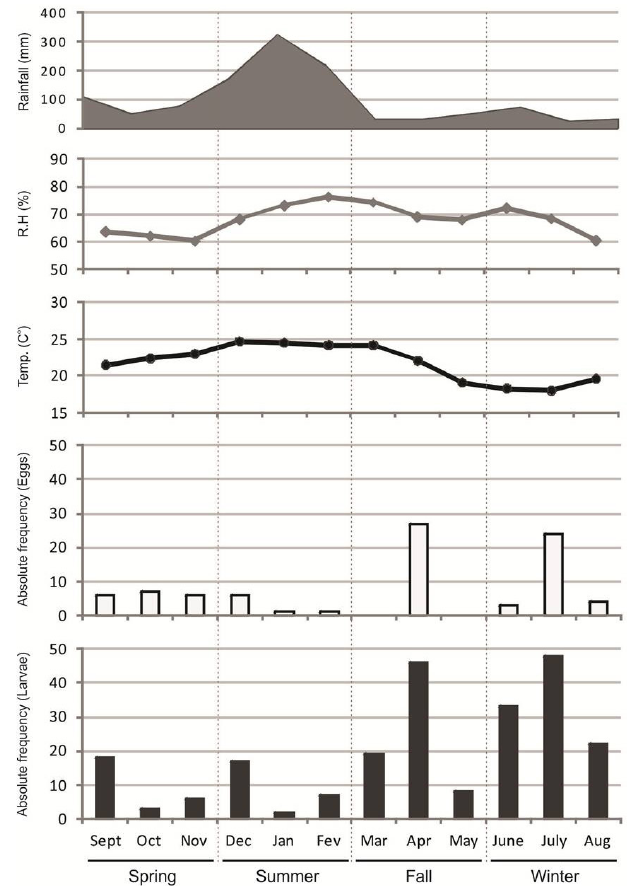
Fig 1 . Graphical interface of absolute frequency (Abs) of disappearance of eggs and larvae from cells of M. montei nests, temperature (° C), relative humidity and rainfall rate (mm) according to the months and seasons from March 1999 to September 2000. Table 1 . Absolute frequency (Abs) and percentage (%) of eggs and larvae removed from the cells of M. montei ’s nests according to the months and seasons, considering the average temperature (° C), relative humidity and rainfall rate (mm) from March 1999 to September